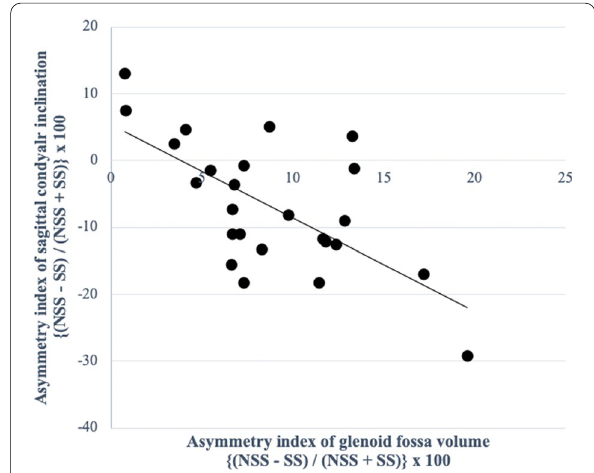
Fig. 6 Simple regression analysis of the asymmetry index of the glenoid fossa volume and the sagittal condylar inclination in the mandibular asymmetry group. X ‑axis, asymmetry index of the glenoid fossa volume; Y ‑axis, asymmetry index of the sagittal condylar